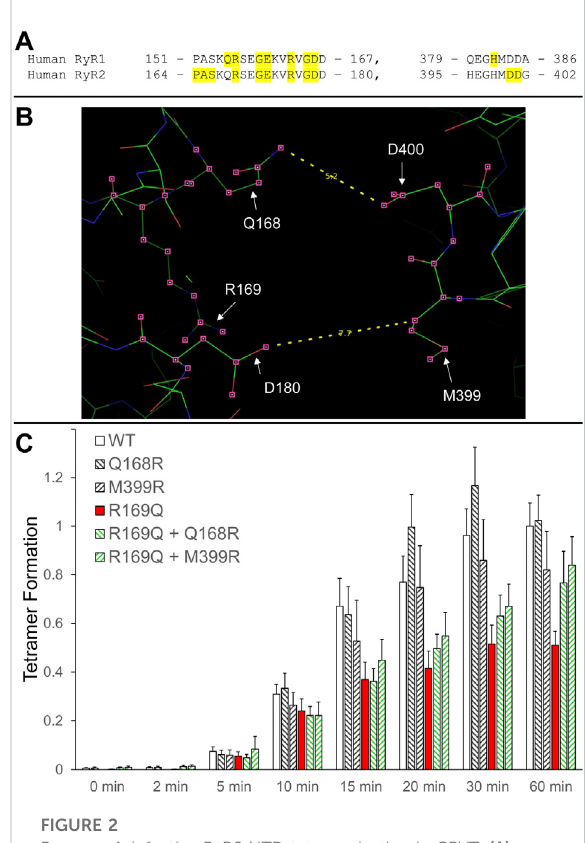
FIGURE 2 Rescue of defective RyR2 NTD tetramerization in CPVT. (A). Peptide sequence of RyR1/2 β 8- β 9 (left) and β 23- β 24 loops (right). RyR1 and RyR2 pathogenic mutations are shaded and listed in Table 1. (B). Image of the RyR2 N-terminal inter-subunit interface generated using PyMol from the RyR2 closed state (5GO9) structure. The location of the CPVT mutation R169Q, as well as residues Q168 and D180 on one subunit that are in close apposition to residues M399 and D400 on the neighboring subunit, are depicted. The Q168-D400 and D180-M399 distances (in Å) are also indicated. (C) . Chemicalcross-linking assays ofNT WT (human RyR2 residues 1 – 906, cMyc-tagged), NT Q168R , NT M399R , NT R169Q , NT R169Q+Q168R and NT R169Q+M399R expressed in HEK293 cells. Cell homogenates were incubated with glutaraldehyde for the indicated time points under reducing (10 mM DTT) conditions and analyzed by Western blotting using Ab cMyc . Densitometry analysis was carried out on the bands corresponding to tetramer and monomer moieties and used to calculate tetramer formation. Data (n ≥ 7) are given as mean value ±SEM.